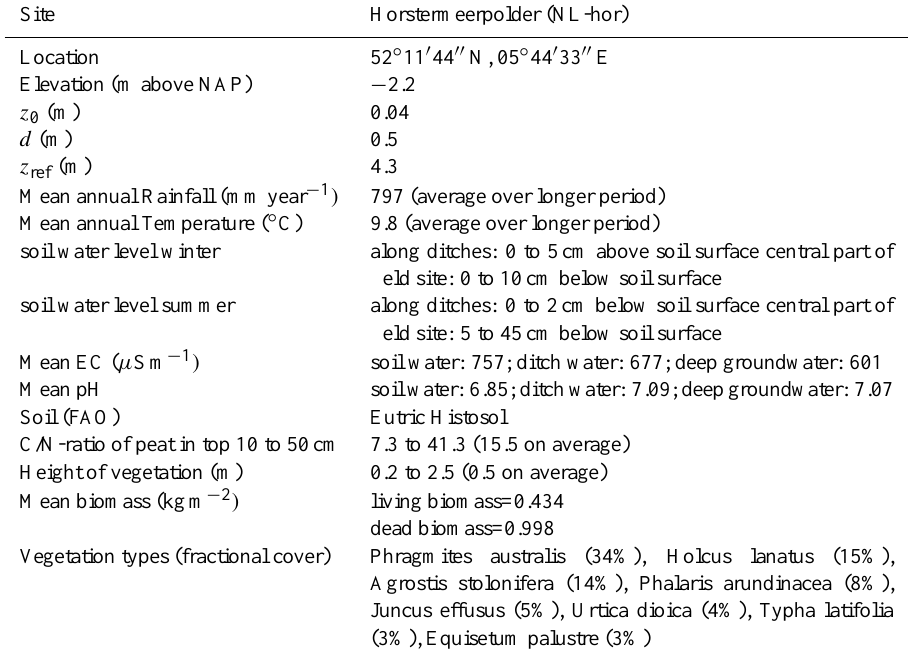
Table 2. Site description: elevation, roughness length ( z 0 ) , zero plane displacement ( d ), reference height ( z ref ) , rainfall, temperature, water level, electrical conductivity (EC), pH, soil type and C/N-ratio, biomass and dominant vegetation types. Data observed over 2005 and